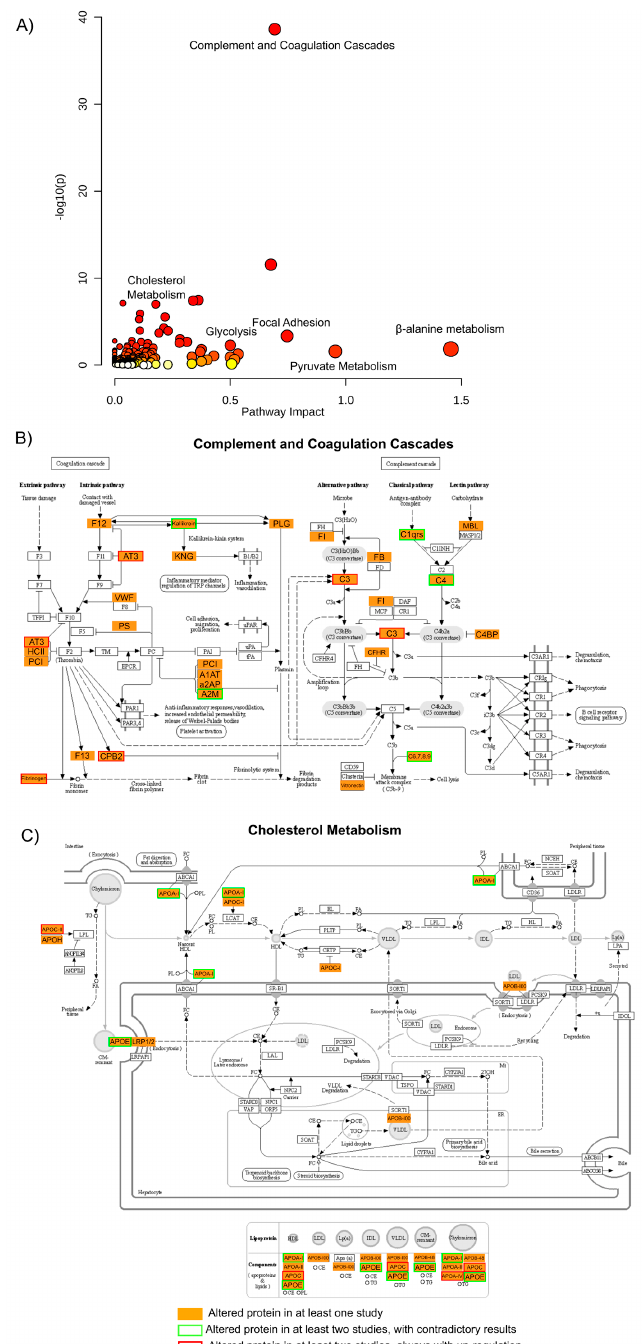
Figure 5. Gene ontology analysis of all altered proteins. ( A ) A gene ontology approach was used to assess pathway impact and enrichment (here presented by the p -value and color scheme) of the 264 proteins described as altered in BD vs. CTR in at least one study (Supplementary Information, Table S2), represented here as a scatter plot [59]. From the pathways shown as enriched by this list of proteins, two were selected and their visual representation obtained through KEGG Mapper Color tool [60]: ( B ) complement and coagulation cascades, and ( C ) cholesterol metabolism. In these last two panels, the proteins found in any of the studies are shown in orange, and proteins found to be altered in at least two studies are highlighted in red when the protein is always found to be up-regulated in BD cases or highlighted in green when the results from the two or more studies are